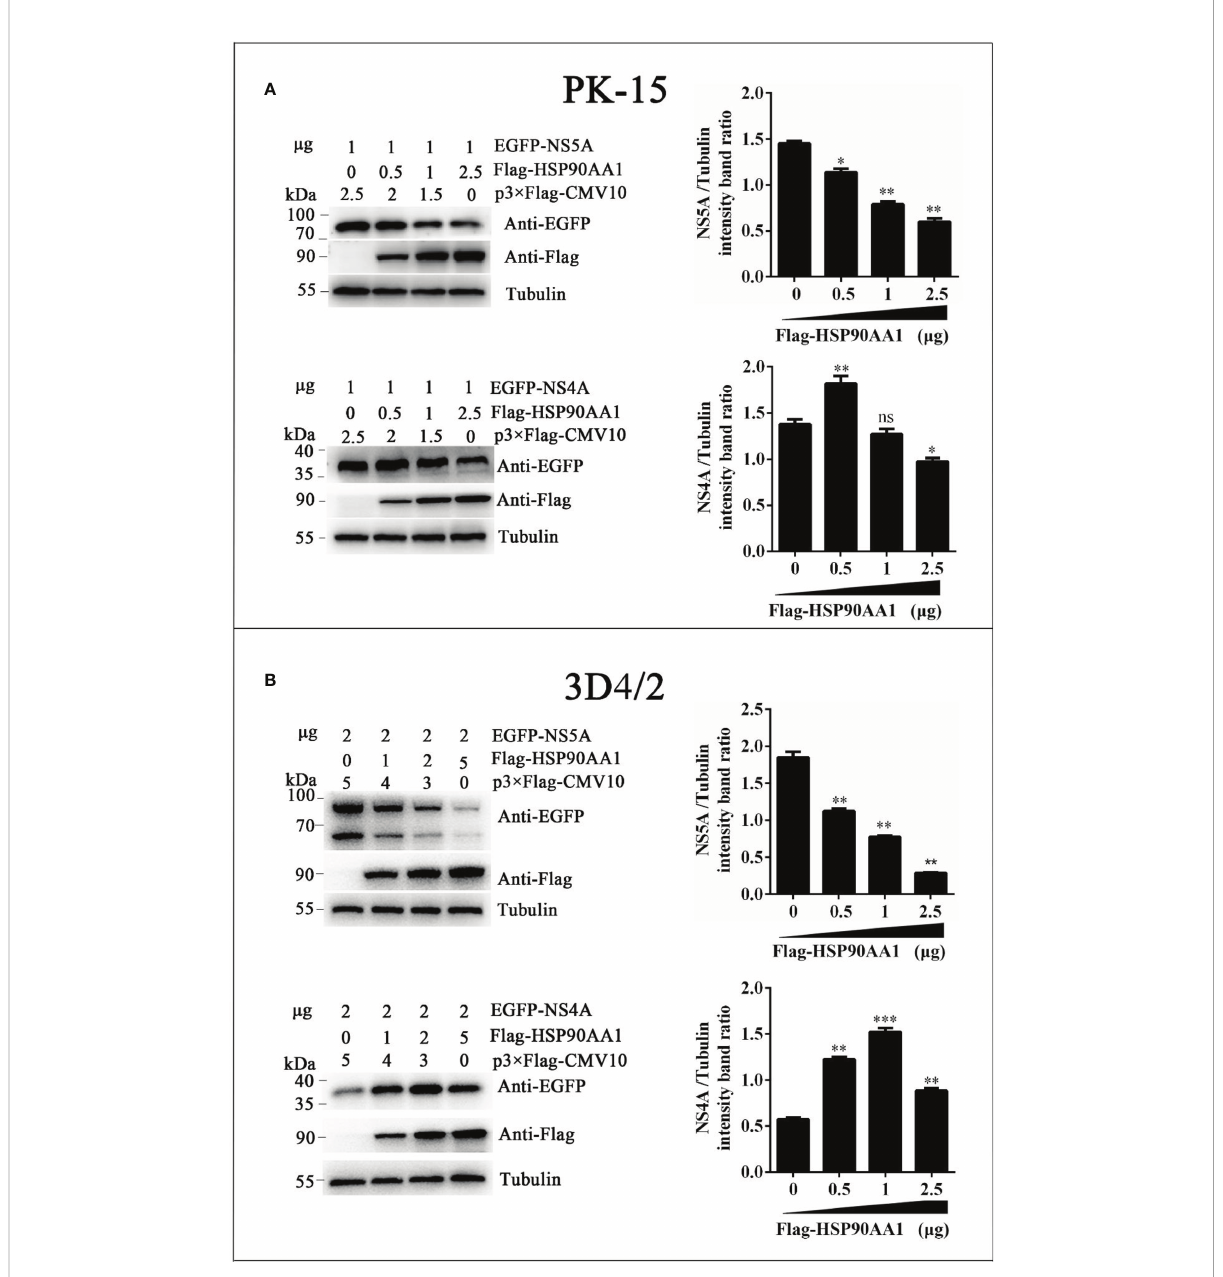
FIGURE 5 HSP90AA1 reduces the protein levels of CSFV NS5A. (A, B) EGFP-NS5A or EGFP-NS4A protein expression in HSP90AA1-expressing PK-15 and 3D4/2 cells. PK-15 and 3D4/2 cells were co-transfected with pEGFP-NS5A or EGFP-NS4A with a different amount of p3×Flag-HSP90AA1. Western blot analyzed EGFP- NS5A or EGFP-NS4A protein expression at 24 hours post co-transfected. Tubulin served as an internal control. The relative levels of EGFP-NS5A or EGFP- NS4A were estimated by histograms representing density reading of the gel bands with Image J, and the ratios were calculated relative to tubulin control. (*p < 0.05, **p < 0.01 and ***p < 0.001 calculated using one-way ANOVA, ns, not signi fi